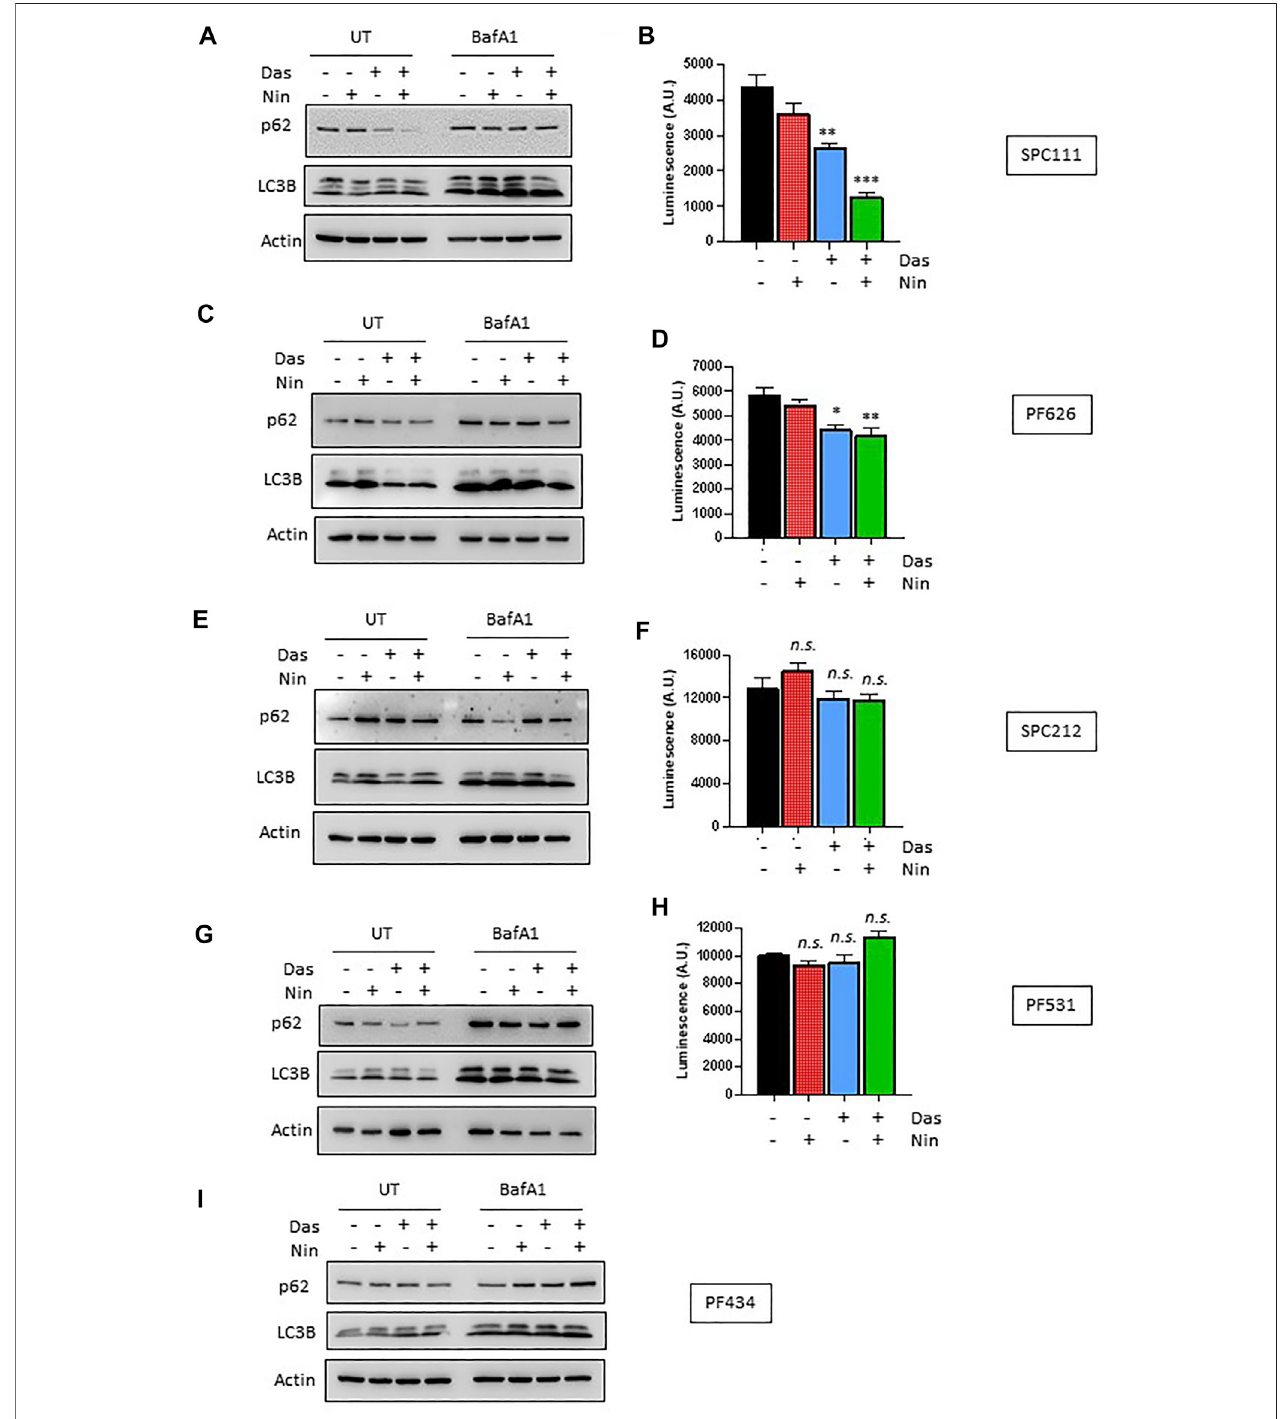
FIGURE 4 | Autophagic response to dasatinib and nintedanib differs across different MPM cell lines. Autophagic fl ux of the indicated MPM cell lines was analyzed after treatment (Das: dasatinib 50 nM; Nin: nintedanib 1 μ M; 24 h) with or without Ba fi lomycin A1 (Baf A1, 100 nM) by western-blot (A,C,E,G,I) , and HiBiT-LC3 luminescence (B,D,F,H) .Barsareaverage±SEMofthreeindependentexperiments.*, p < 0.05;**, p < 0.01;***, p < 0.001, n.s. ,non-signi fi cant, t -test.NotethatPF434 cells did not express the LC3-HiBiT after G418 selection despite multiple attempts.